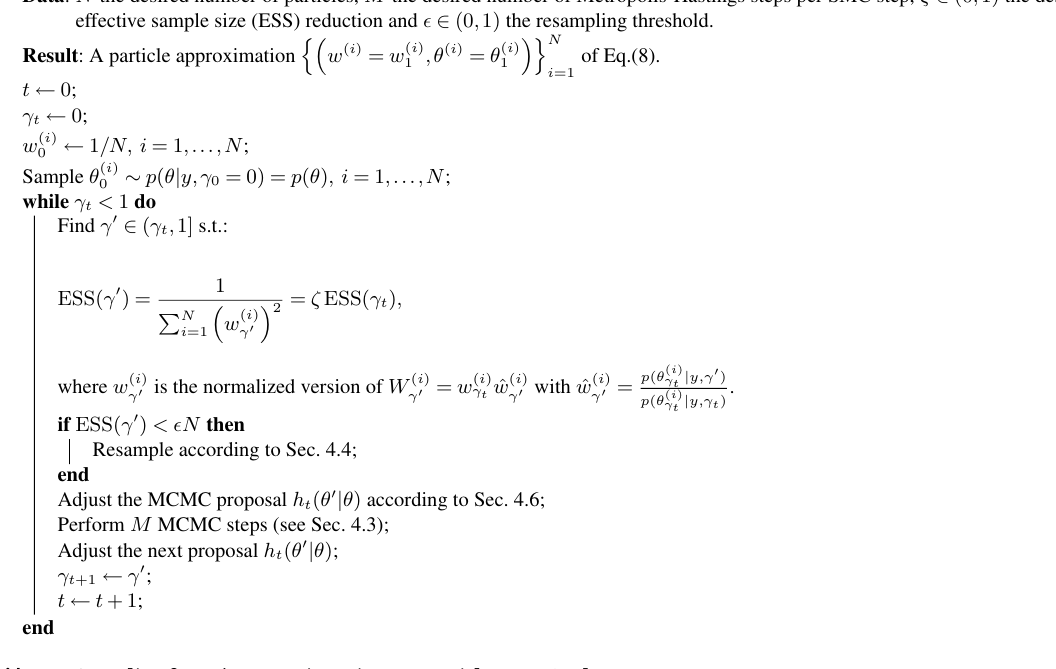
Fig. 1: Adaptation of γ t for the twin experiment (a) and the calibration (b). The small jumps indicate the locations where resampling occurs.